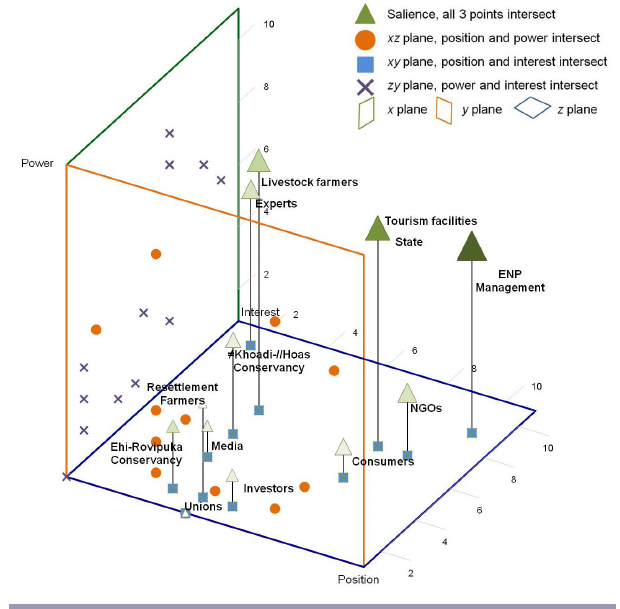
Fig. 4 . Scatter plot of stakeholder salience in a three- dimensional co-ordinate system. The median position scores of all stakeholder groups are plotted on the x axis, the median interest scores on the y axis, and the median power scores on the z axis. The markers indicate where stakeholder attributes intersect, i.e., circles indicate where position and power intersect, squares indicate where position and interest intersect, and crosses indicate where power and interest intersect. The triangles show stakeholder salience, where all three points of stakeholder attributes intersect. The size and shade of the triangle depicts the difference in salience among the different stakeholder groups, i.e., the groups with larger, darker triangles have higher salience